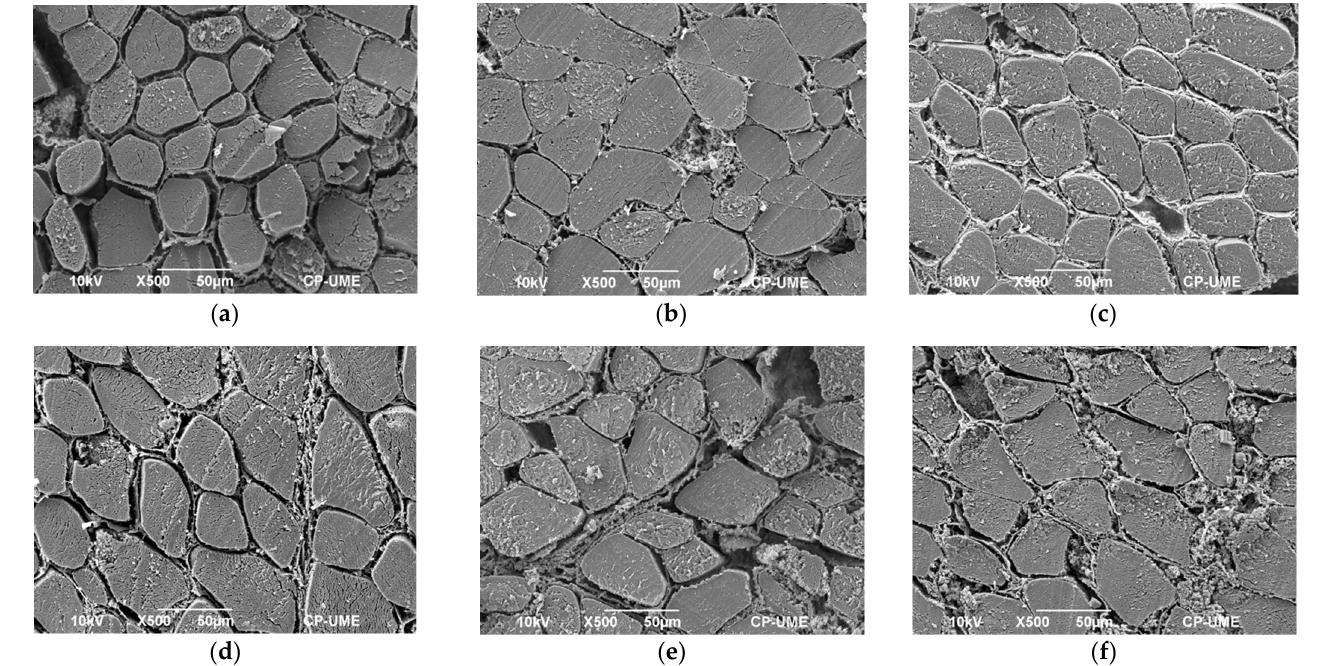
Figure 3. Cross ‐ sectional scanning electron micrographs of bovine Longissimus lumborum stored for 7 d at 4 °C treated for 50 min with HIU: ( a ) HIU bath, lower area exposed to emitters; ( b ) HIU bath, upper unexposed area; ( c ) HIU probe, unexposed lower area; ( d ) HIU probe, upper area exposed to probe; ( e ) control without HIU, lower area; ( f ) control without HIU, upper area.